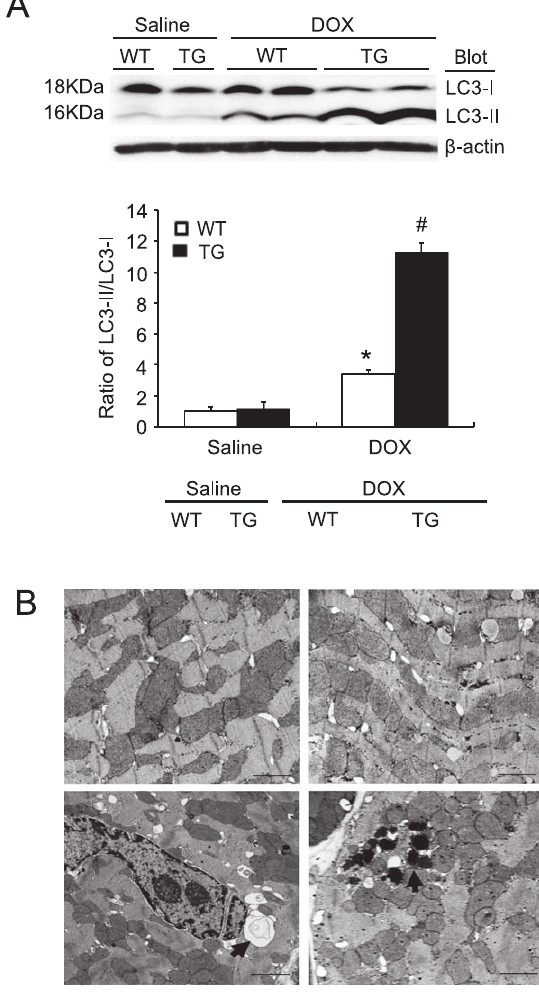
Figure 4. Nrdp1 TG mouse hearts are more susceptible to DOX- induced autophagy. A. Western blot analysis of ratio of LC3-II to -I protein level from WT and Nrdp1 TG heart tissue after saline or DOX treatment. A representative blot is shown for each condition (top panels). b -actin was used as a loading control. Histograms show relative intensity of the ratio of LC3-II to -I (n=4 per group) (bottom panel). * P , 0.05 vs WT + saline mice; # P , 0.05 vs WT + DOX mice. B. Representative electron microphotographs of cardiac sections from WT (left panel) and Nrdp1 TG mice (right panel) treated with 20 mg/kg of DOX for 4 days (n=3 per group). Arrows indicate autophagic vacuoles and electron-dense lysosomes. Scale bars=1 m m.